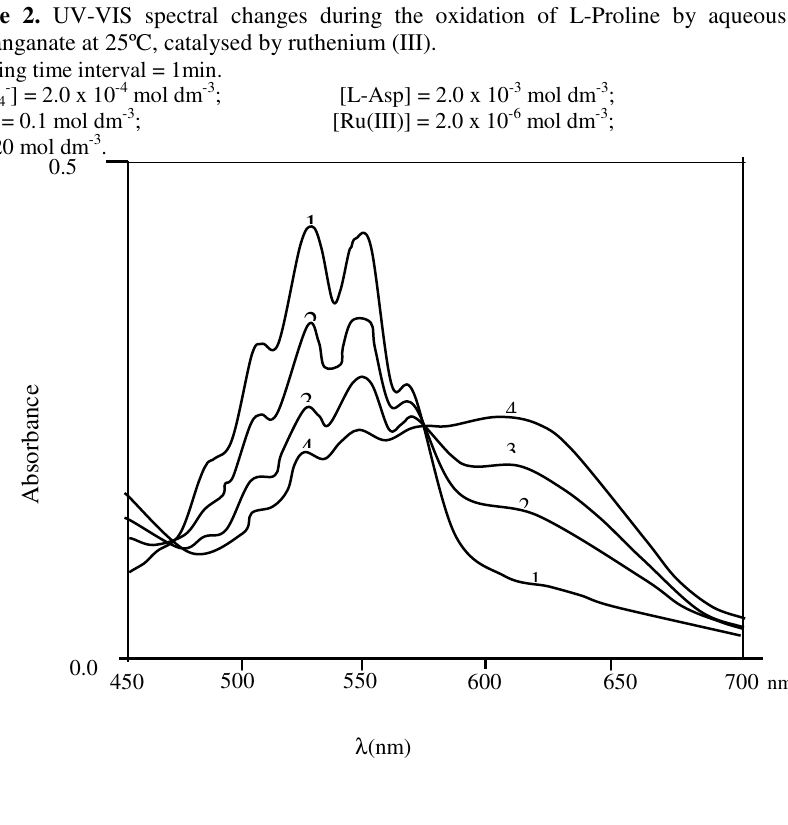
Figure 2. UV-VIS spectral changes during the oxidation of L-Proline by aqueous alkaline permanganate at 25ºC, catalysed by ruthenium (III). Scanning time interval =